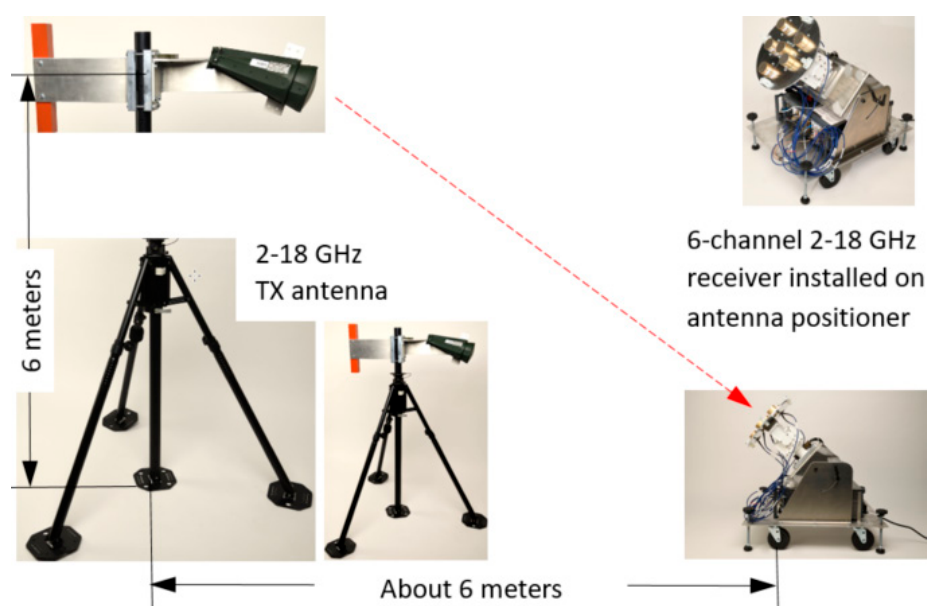
Figure 5. The TX and RX array assemblies for an open lab test: the measurement setup was in an open area, and the microwave absorbing materials were placed in front of the antenna positioner to absorb ground reflections.